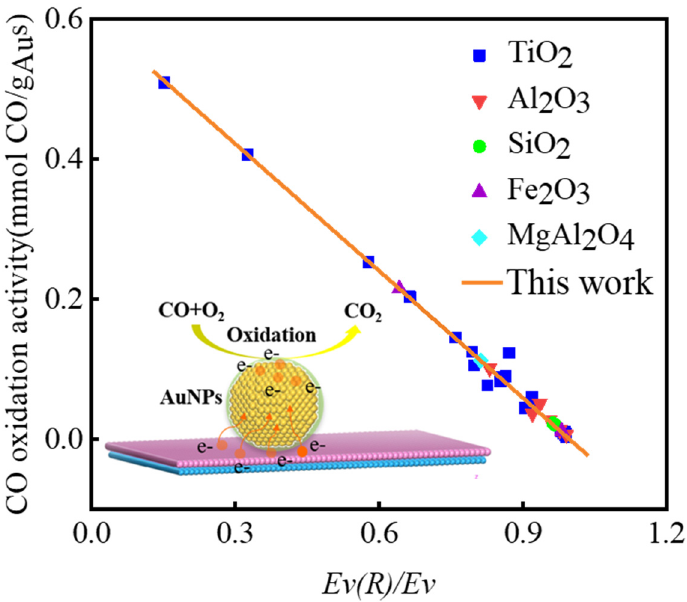
Figure 1. Measured activities for CO oxidation at 273 K over different Au − based catalysts as a function of the vacancy formation energy. (The black dashed line in the graph is the fitted trend line. The points are collected from [41–46].)